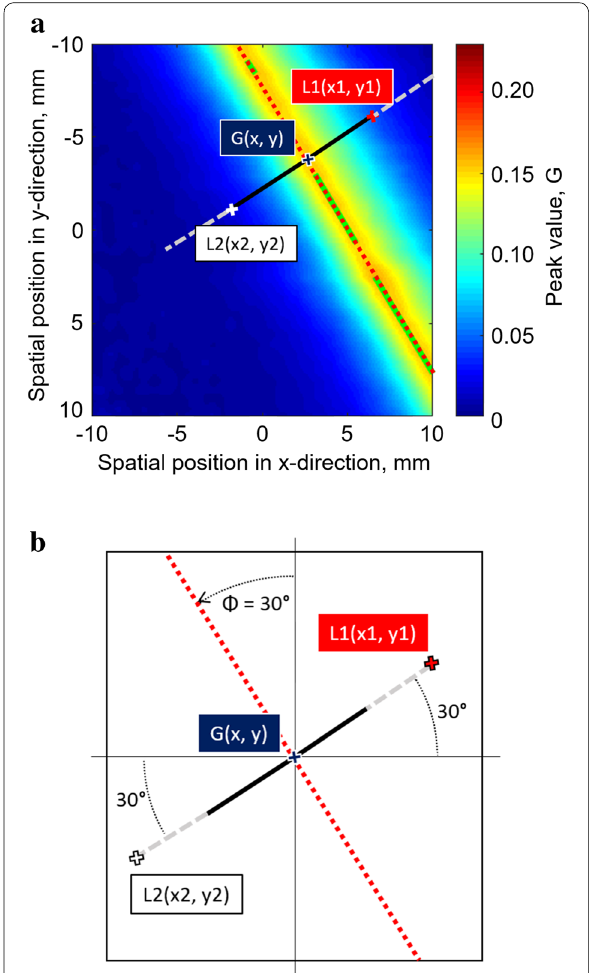
Figure 3 ( a ) Linear scan orthogonal to the extrapolated crack axis, and ( b ) illustration of the extraction of linear scan in a vector